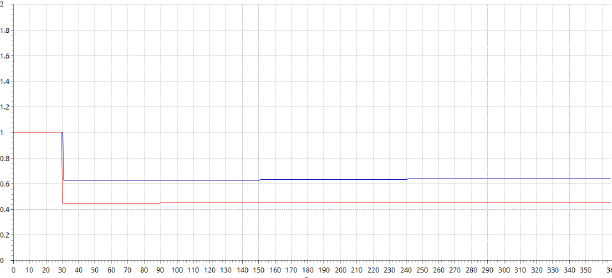
Figure 23. Service Level of Scenario II Optimized.